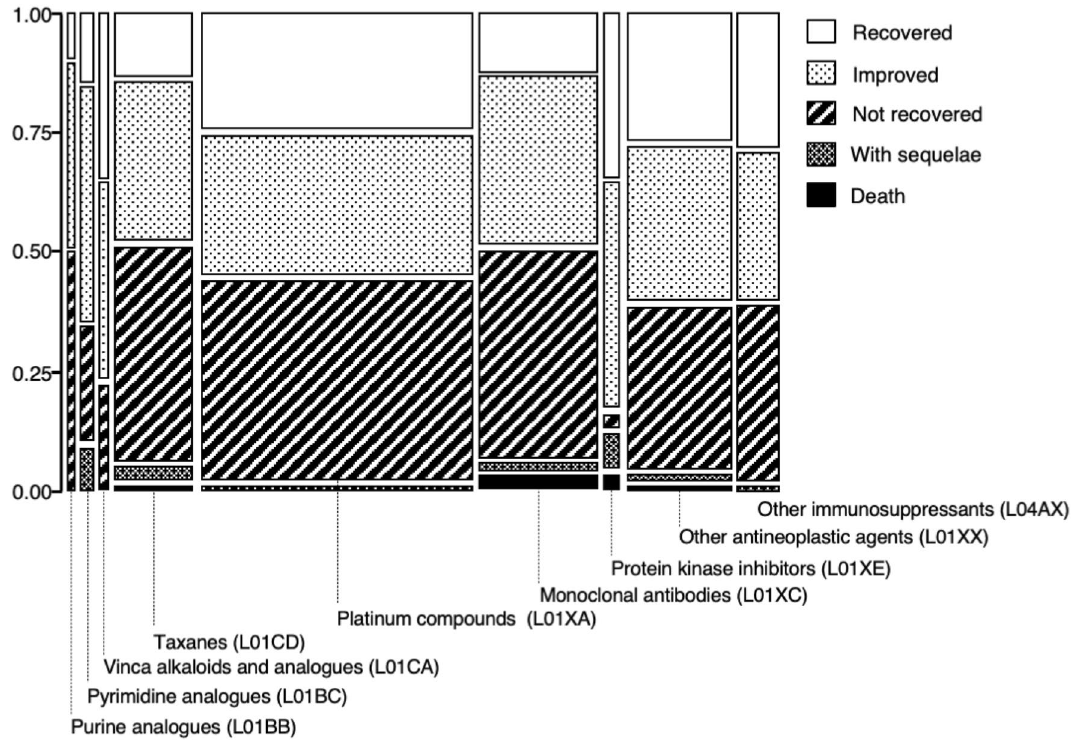
Figure 4. Mosaic plot of outcomes of chemotherapy-induced peripheral neuropathy. The plot is divided into rectangles where each vertical length represents the proportion of each level of the Y variable within each level of the X